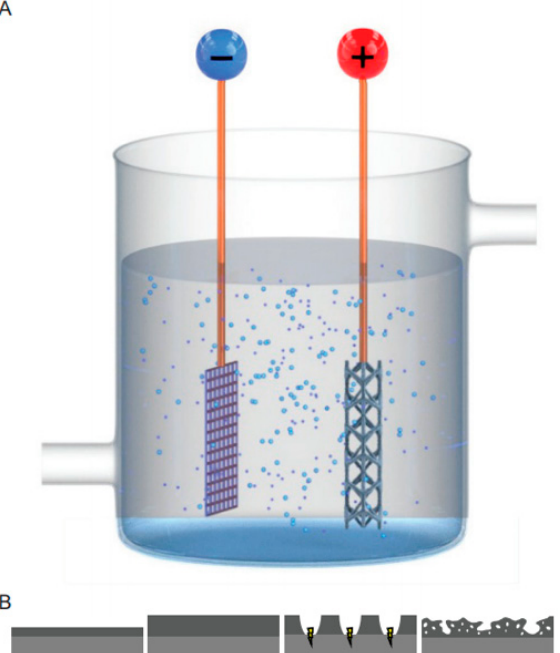
Figure 3. ( A ) A schematic drawing of the plasma electrolytic oxidation (PEO) setup with a cathode and an anode (implant). ( B ) During PEO processing, initially the titanium oxide layer grew outwards. After dielectric breakdown, plasma discharge occurred at the surface, resulting in a highly porous structure.